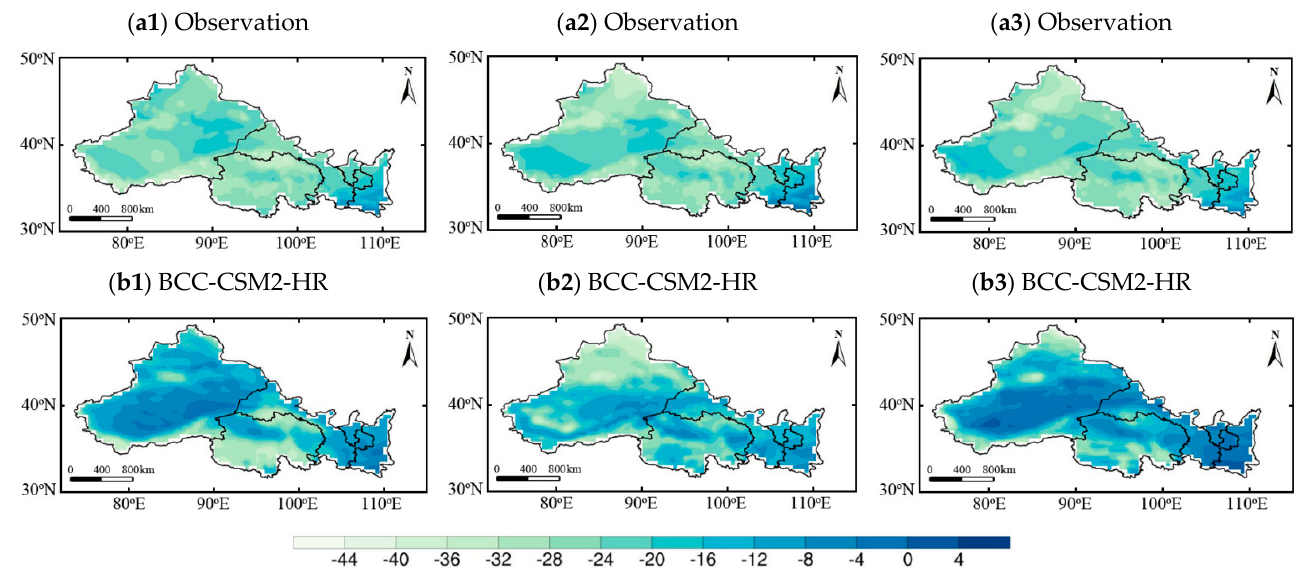
Figure 9. Distribution of extremely high temperatures in Event 1 ( left ), Event 2 ( middle ), and Event 3 ( right ) over Northwest China: observations and the values simulated by the BCC-CSM2-HR. Unit: °C.